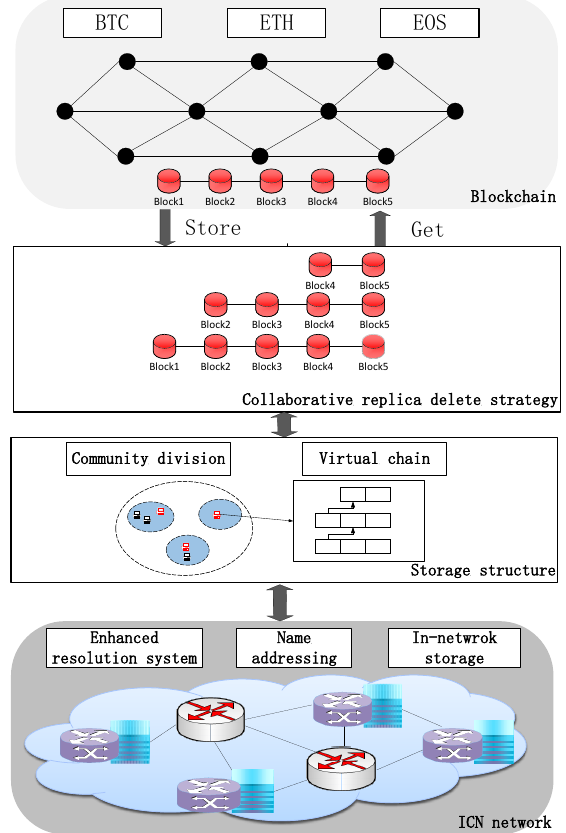
Figure 2. The blockchain storage